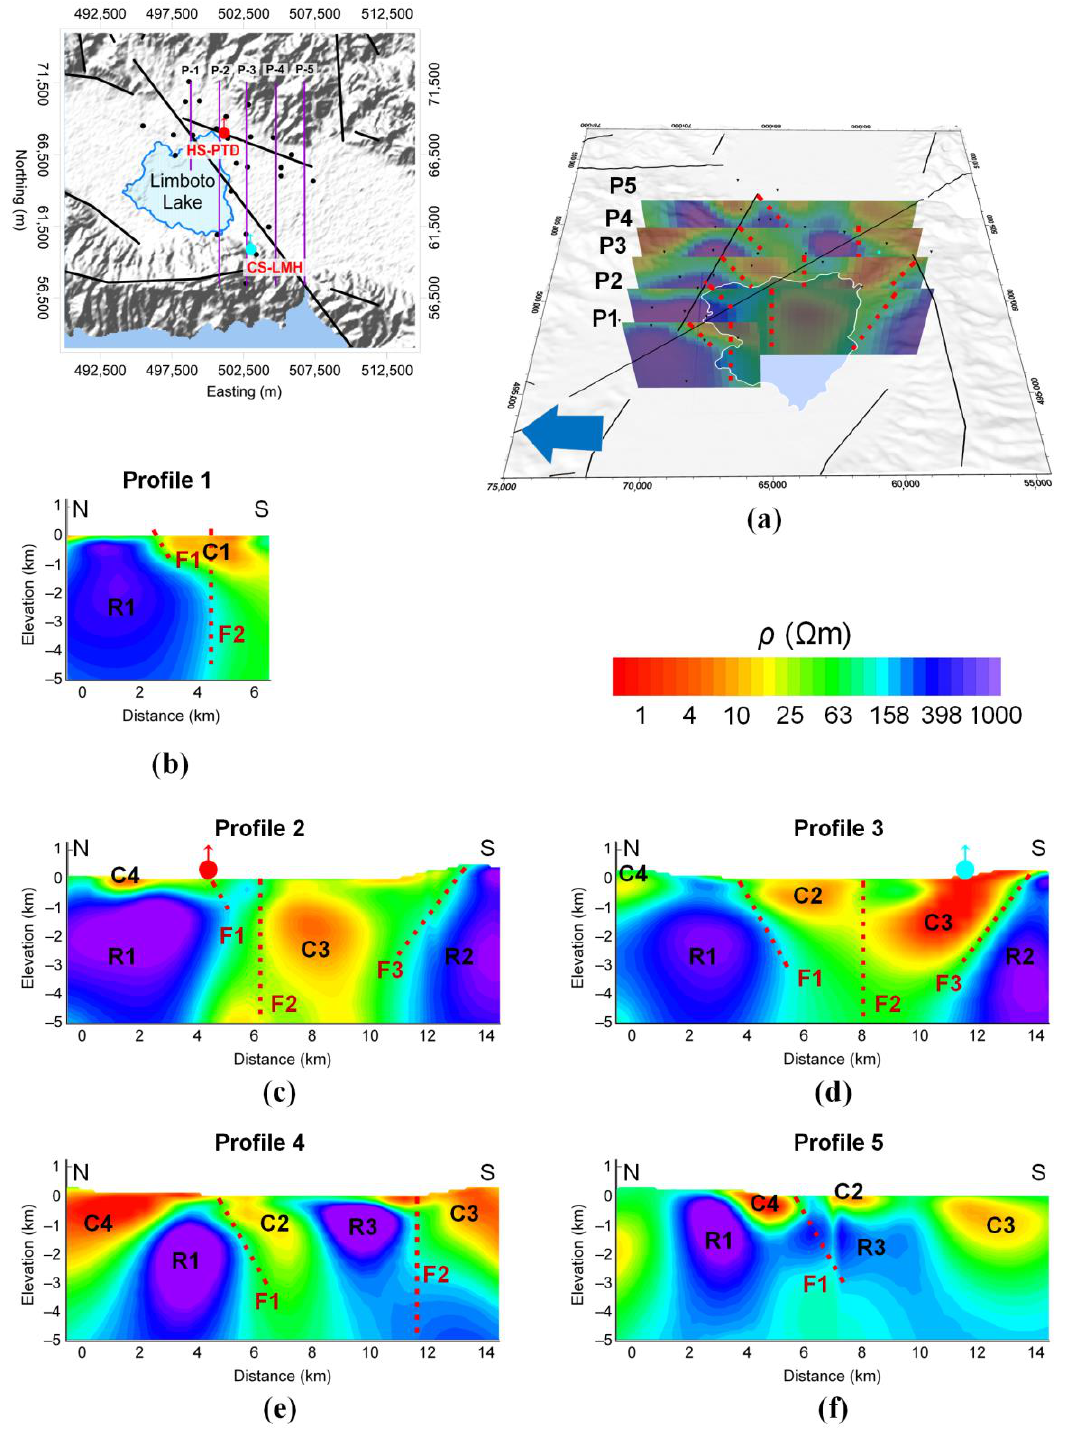
Figure 9. ( a ) Resistivity cross-sections extracted from the 3D resistivity model in the north – south (N – S) direction ( b ) Resistivity cross-sections for Profile 1 ( c ) Resistivity cross-sections for Profile 2 ( d ) Resistivity cross-sections for Profile 3 ( e ) Resistivity cross-sections for Profile 4 ( f ) Resistivity cross-sections for Profile 5. Label C is for conductor and R is for resistor. The dashed red lines denote the interpreted faults characterizing a graben system based on the resistivity contrast.